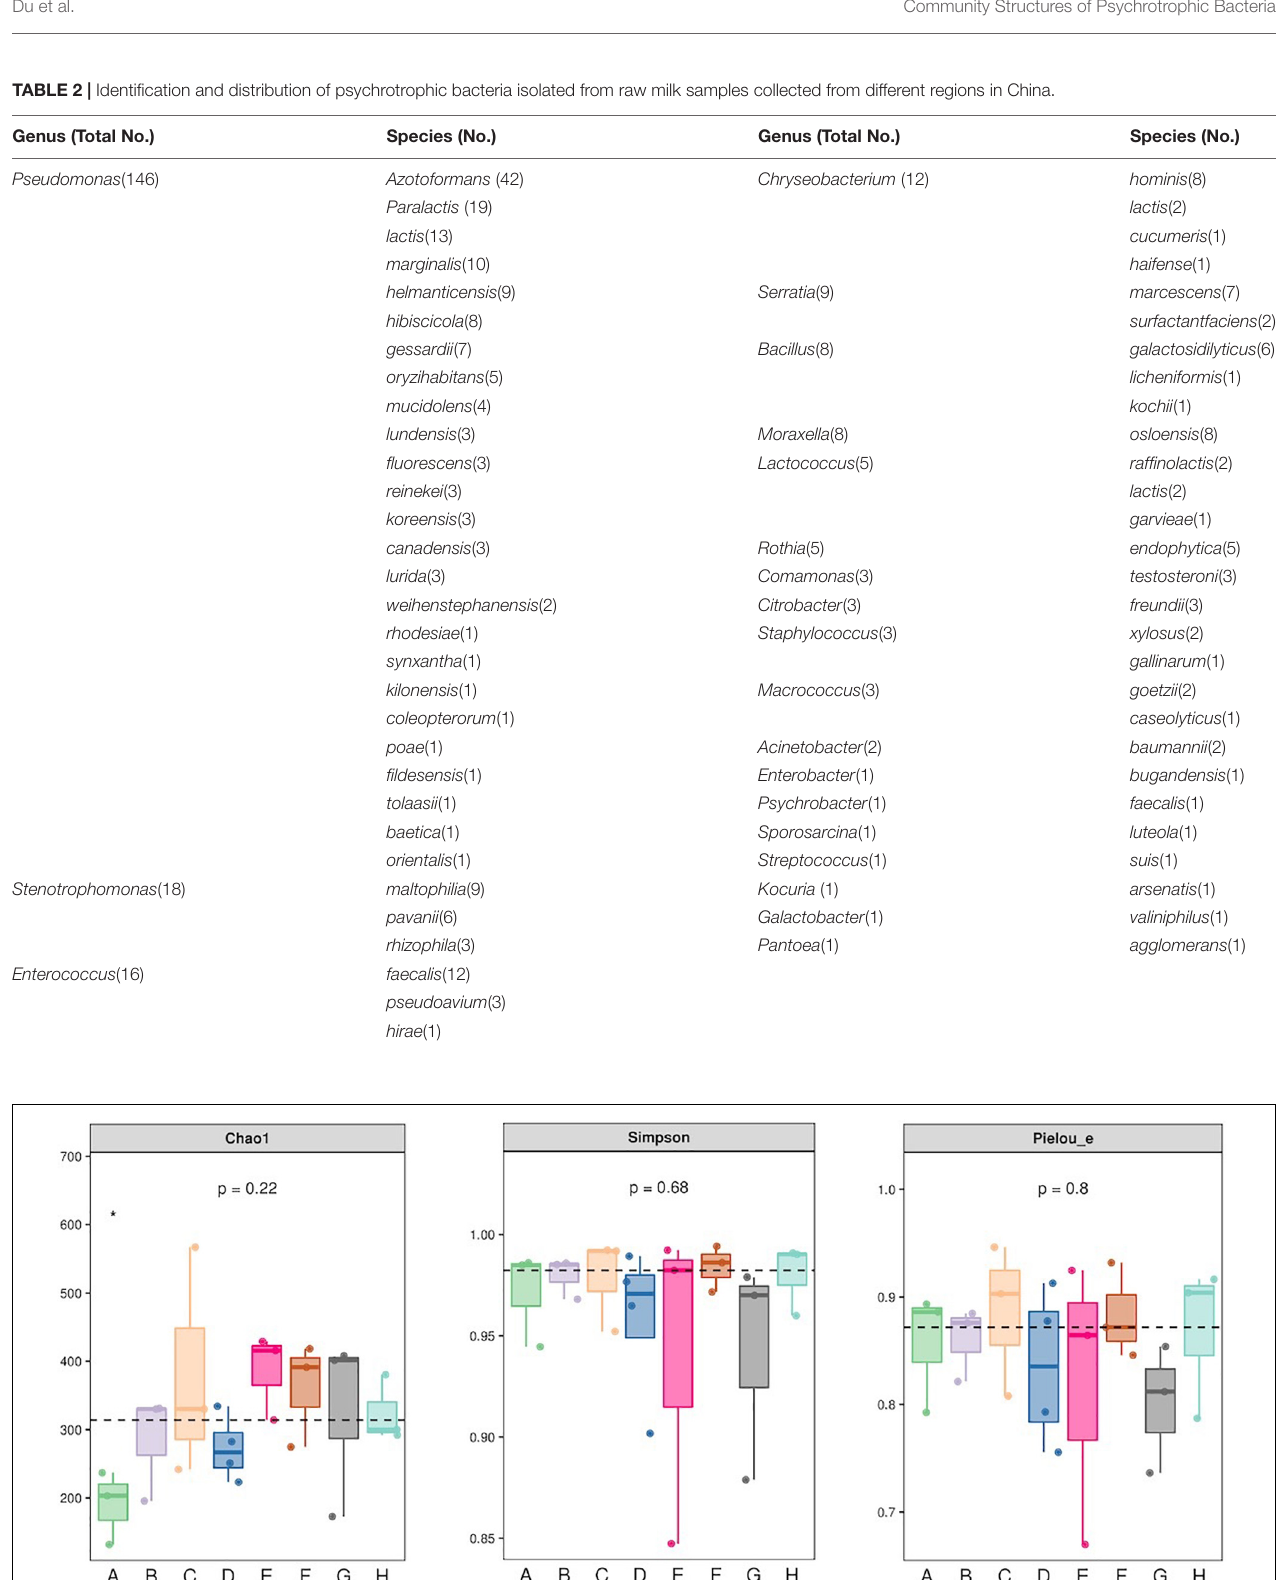
Frontiers in Microbiology |